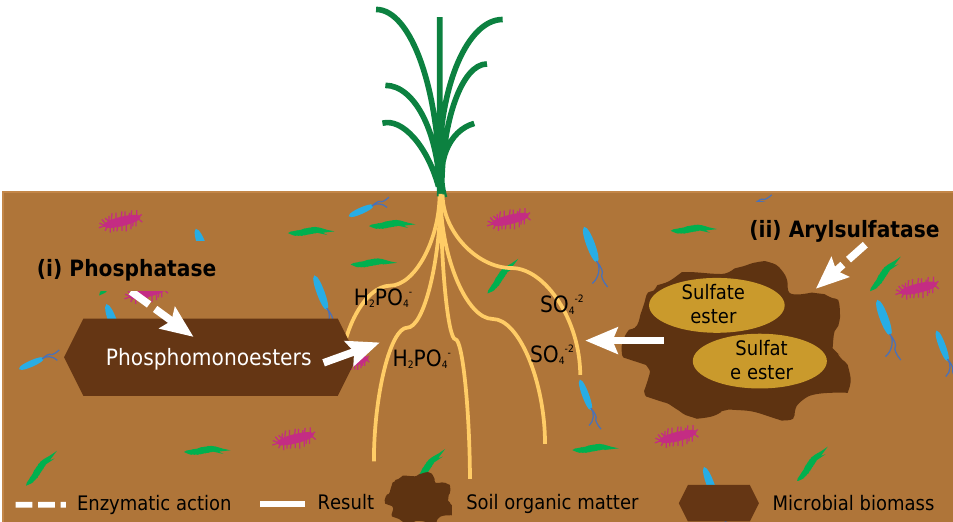
Figure 3. Enzyme phosphatase and arylsulfatase in